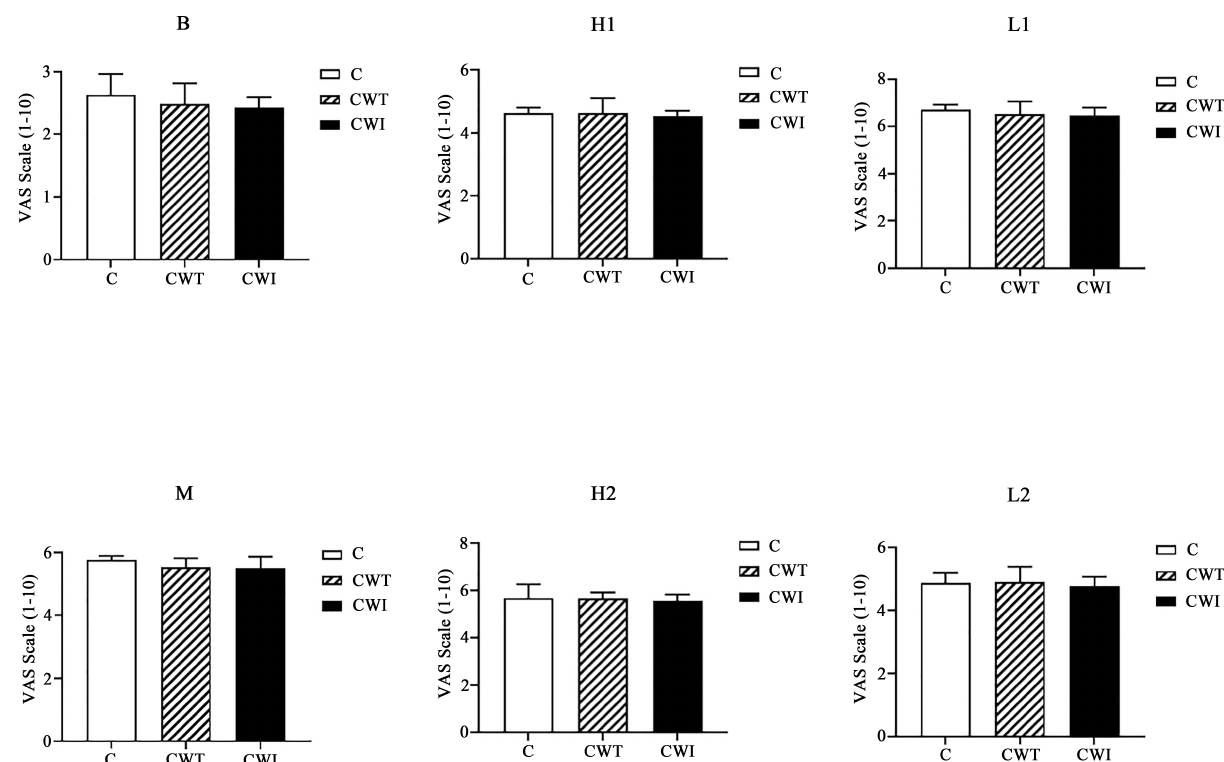
Fig. 5. Muscle soreness values at the 6 times point during study in three